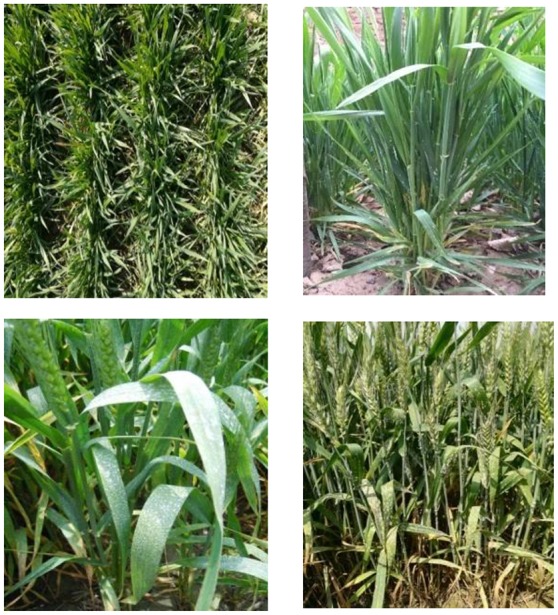
Pictures of the different developmental stages of the infected winter wheat; jointing (left upper), booting (right upper), anthesis (left lower), and filling (left lower).